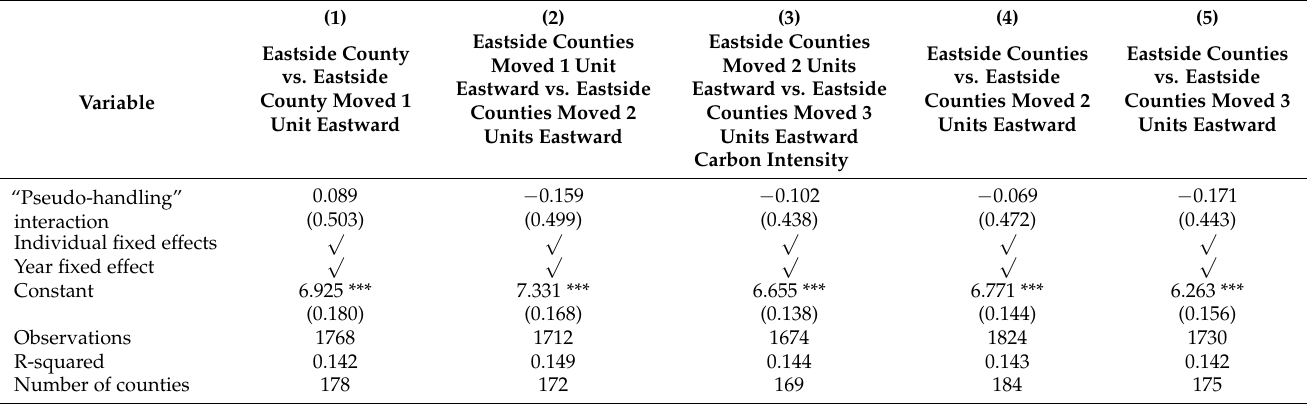
Table 5. “Pseudo treatment-control group”